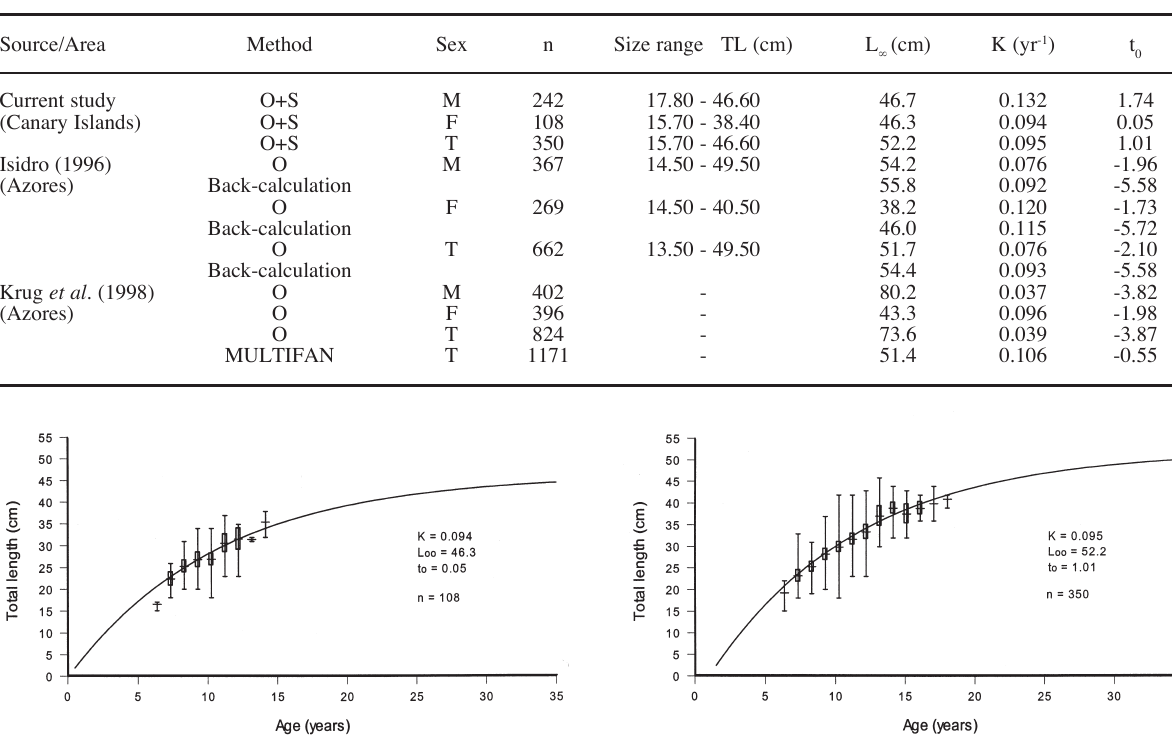
F IG . 8. – Growth curve of Pontinus kuhlii females. Vertical lines represent length range observed and bars indicate mean +/- 2SE.